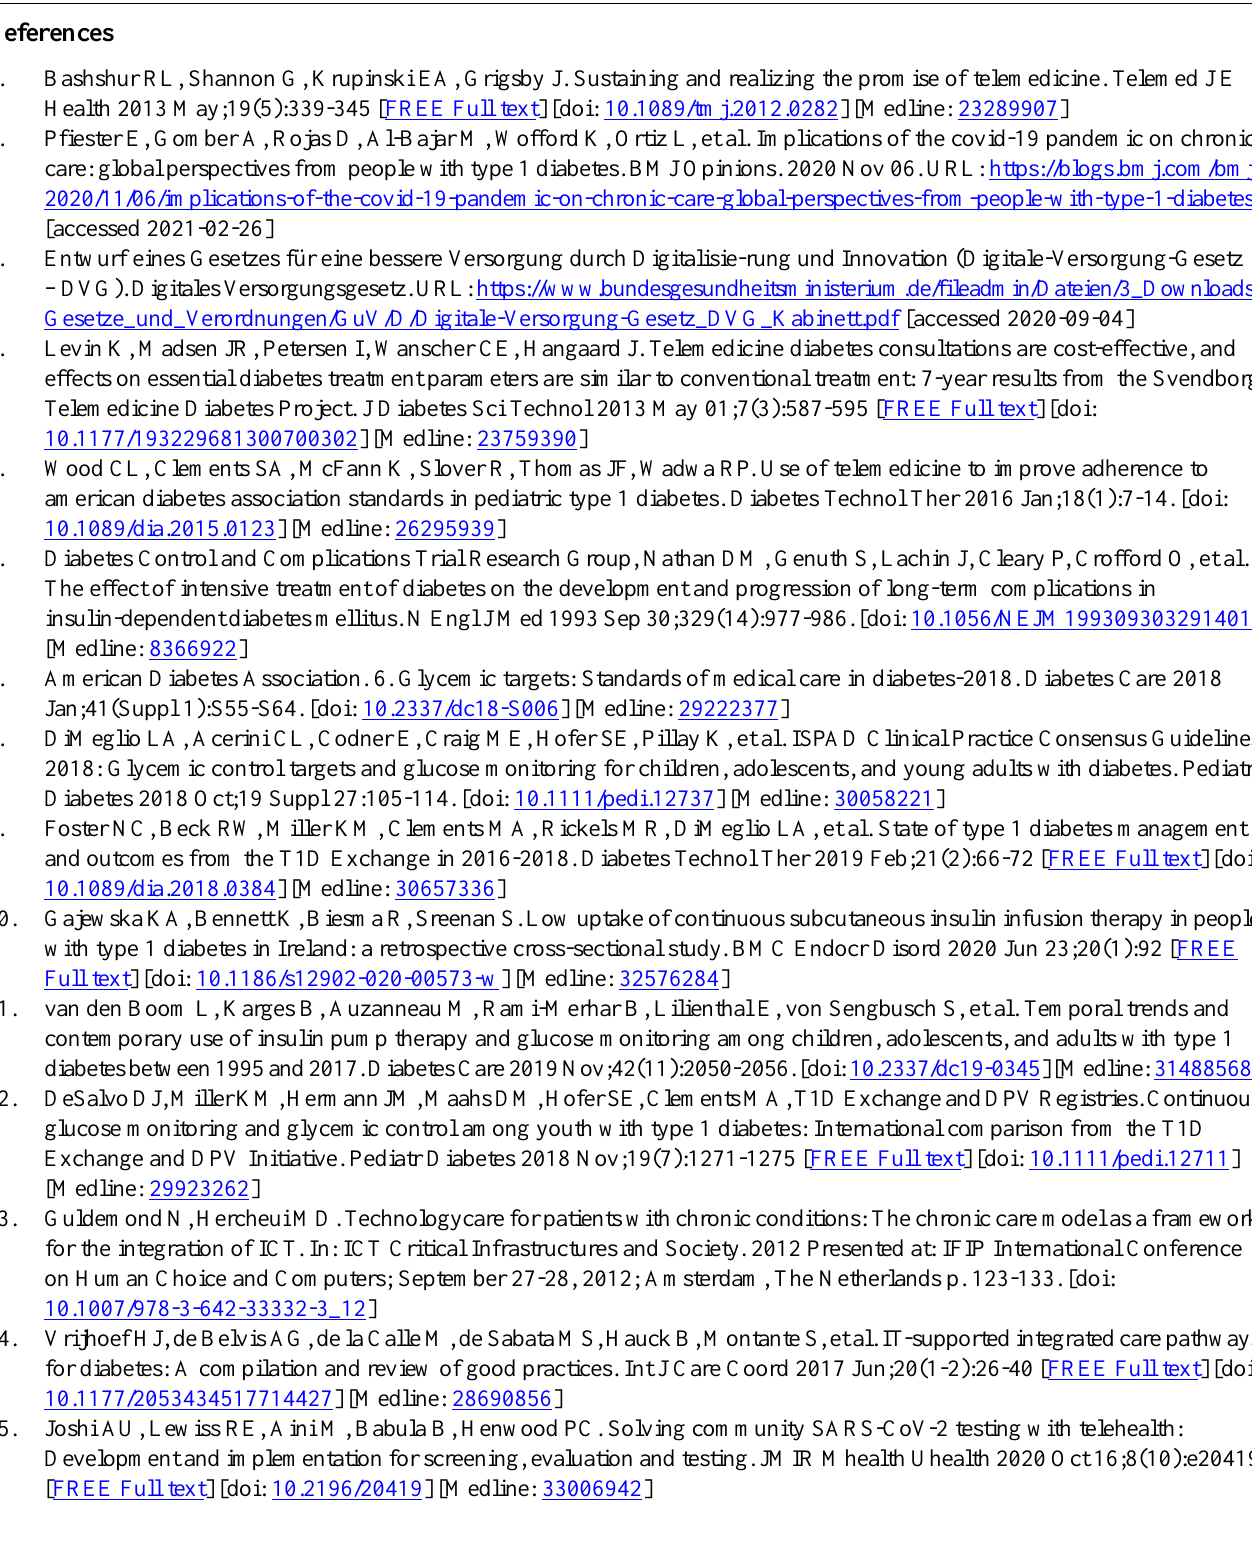
Table S1. Caregiver feedback regarding their experience with remote